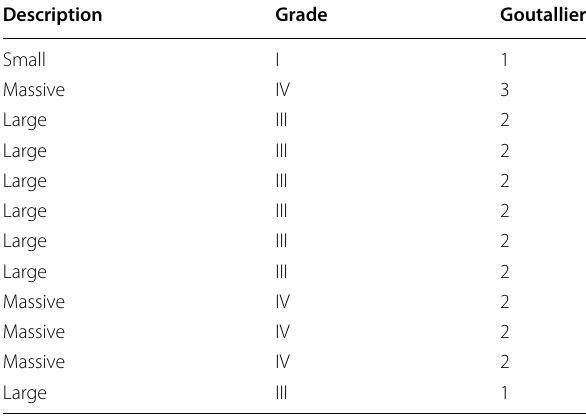
Table 2 Characteristics of the full‑thickness tears according to Bateman and Goutallier